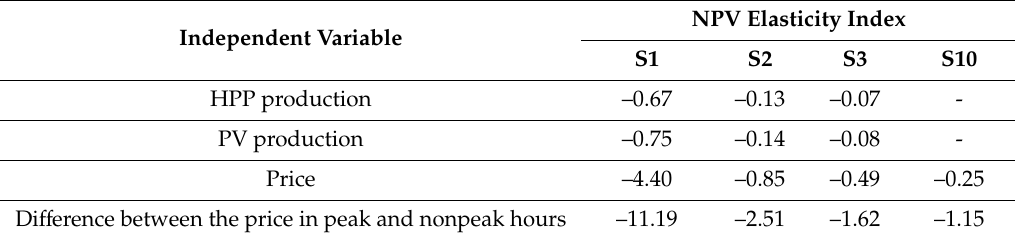
Table 5. NPV elasticity